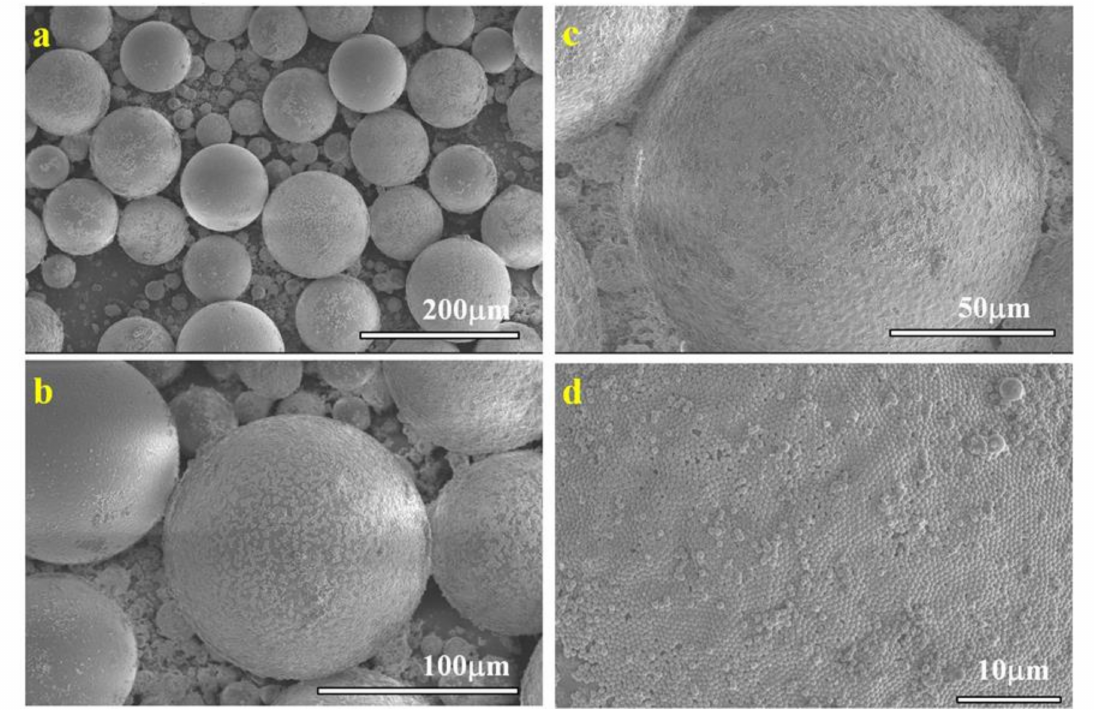
Figure 1. SEM images of PMM microspheres at different magnifications: ( a ) 200 × , ( b ) 500 × , ( c ) 800 × , and ( d ) 2500 × , resulted from the polymerization of Pickering emulsions that varies in size and curvature depending on the surface energy of the nanoparticles. In ( d ), the hexagonal close-packed lattice of the self-assembled monolayer of NPs can be